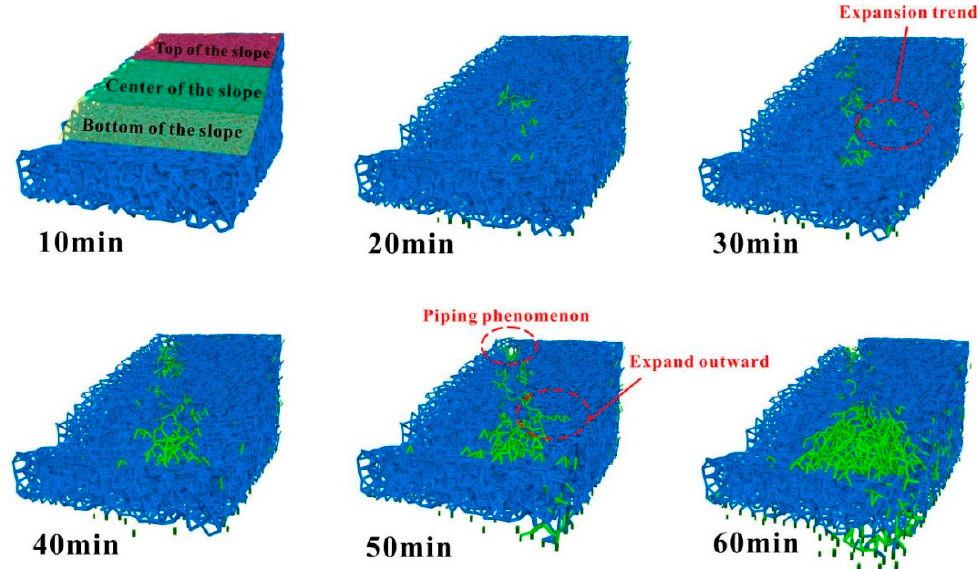
Figure 9. PFC3D force chain mesh destruction.